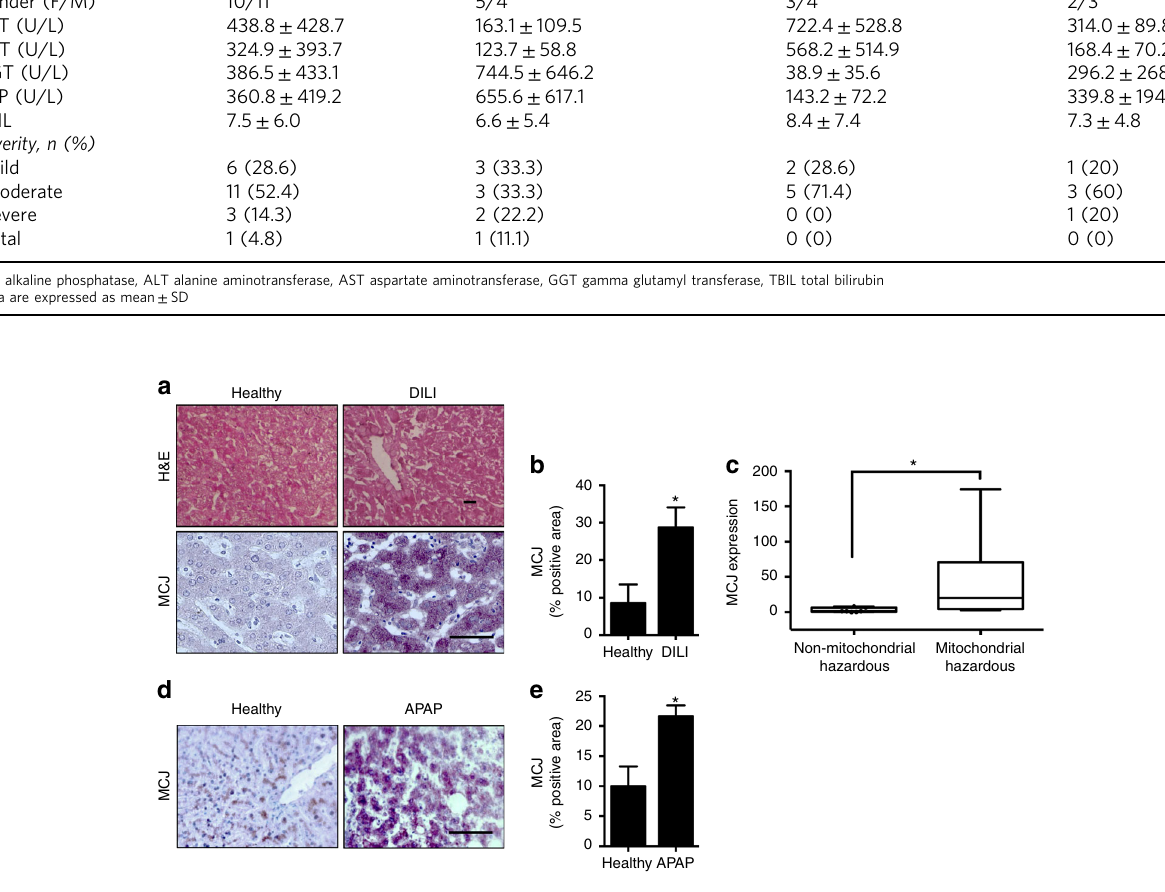
Table 1. MCJ expression was assayed by immunohistochemistry